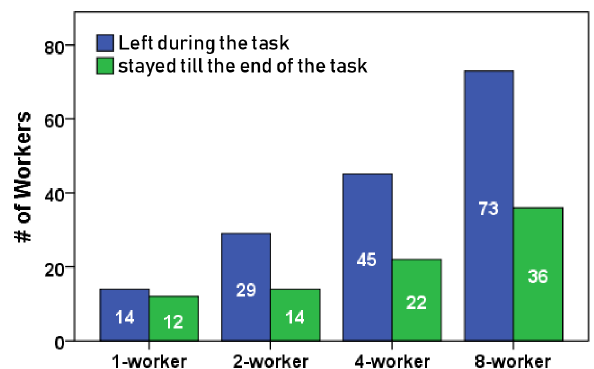
Figure 9. Number of workers who left during the conversational task vs. who stayed till the end of the